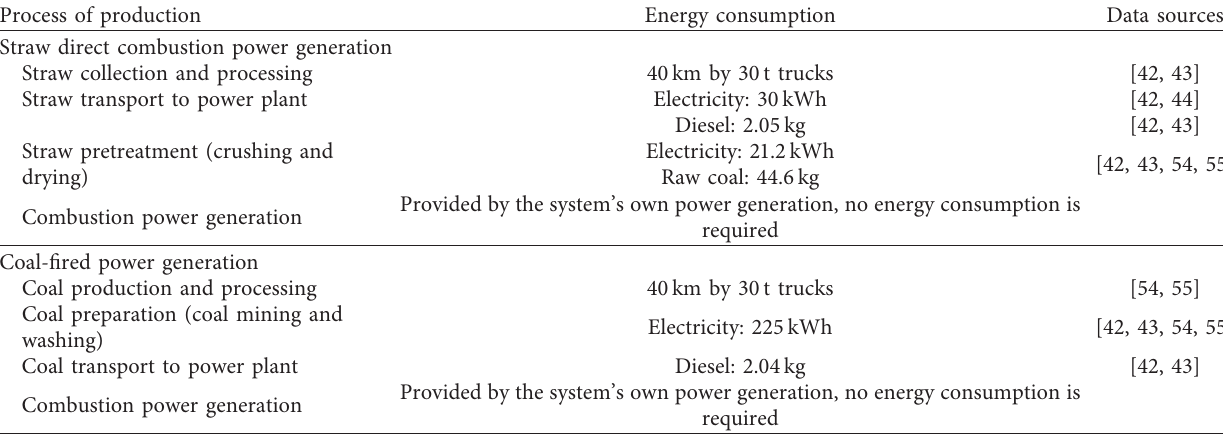
Table 7: LCI data for 1t straw direct combustion and coal-fired power generation.